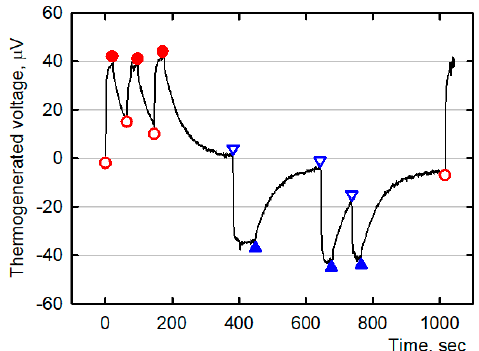
Figure 11. The illustrative time-dependent record of induced voltage in the self-powered signaling sensor by short finger touching at the point A (the finger touch is denoted by open red circles and the finger lift by filled red circles) or at the point B (the finger touch is denoted by open blue triangles and the finger lift by filled blue triangles) of the sensor.